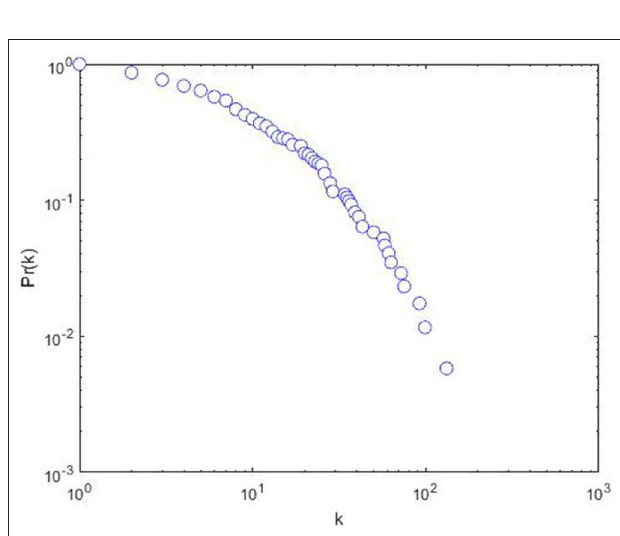
FIGURE 3 | The cumulative distribution of degree on log-log axes.